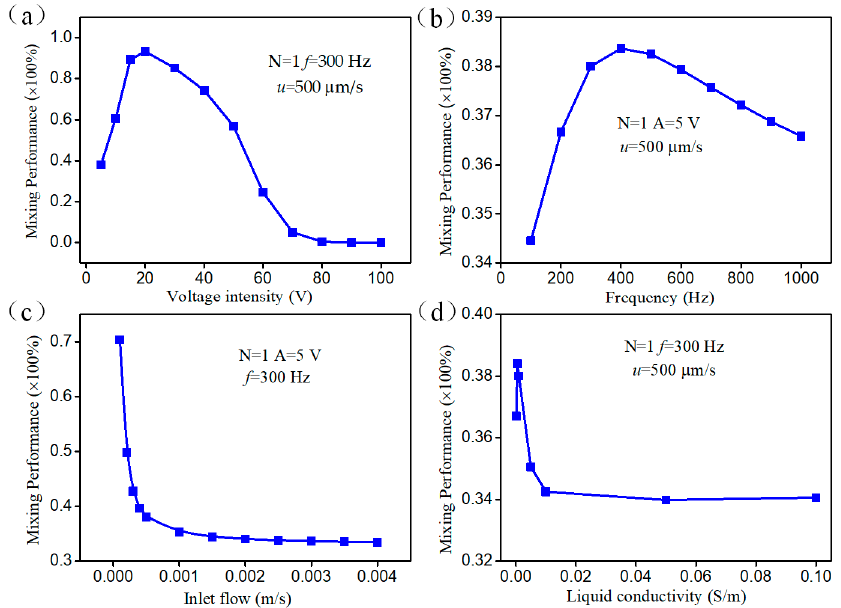
Figure 5. The mixing performance of the micromixer with a pair of herringbone floating electrodes. ( a ) The effect of voltage intensity on mixing performance at f = 300 Hz, u = 500 μ m/s; ( b ) the frequency dependency of mixing performance at A = 5 V, u = 500 μ m/s; ( c ) the relationship between the mixing performance and inlet flow at A = 5 V, f = 300 Hz; ( d ) the mixing performance under different liquid conductivity at A = 5 V, f = 300 Hz and u = 500 μ m/s.